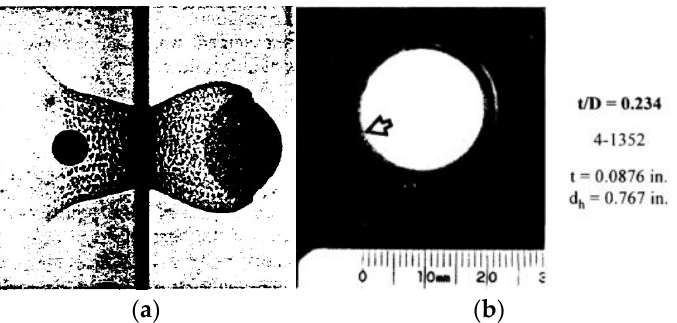
Figure 20. Photos of Piekutowski’s test [34,35]. ( a ) Debris cloud photo in 4-1352 test; ( b ) perforation diameter photo in 4-1352 test.